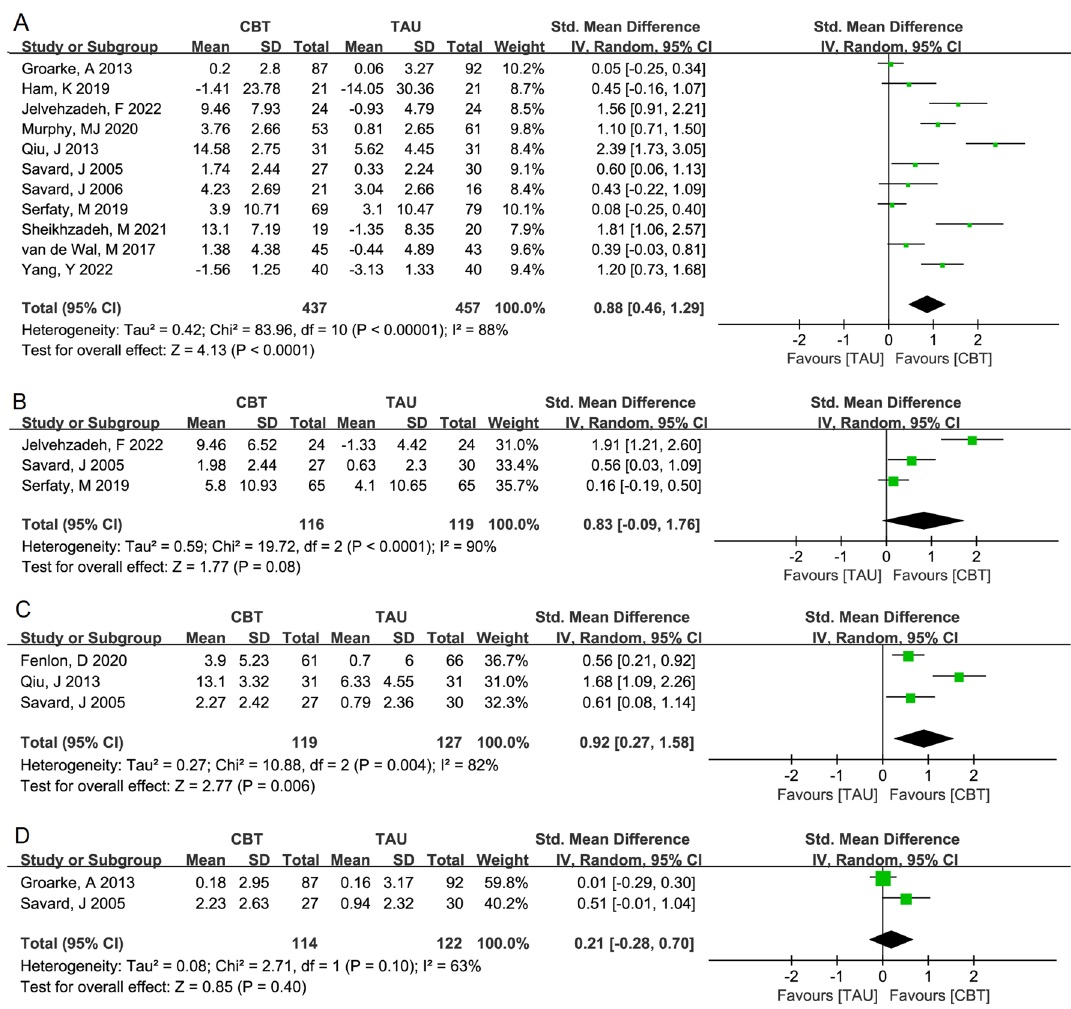
Figure 2. Forest plot of the random effects model meta-analysis of the comparison of the change values of the depression scores between CBT and TAU: ( A ) pre-treatment versus post-treatment, ( B ) pre-treatment versus 3-month follow-up, ( C ) pre-treatment versus 6-month follow-up, and ( D ) pre-treatment versus 12-month follow-up. CBT cognitive behavioral therapy, TAU treatment as